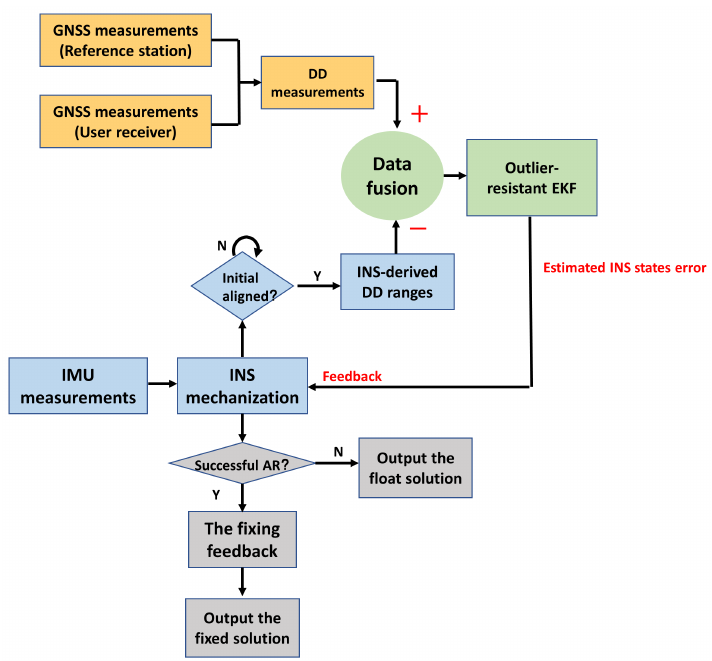
Figure 2. The overview of the TC RTK/INS integration